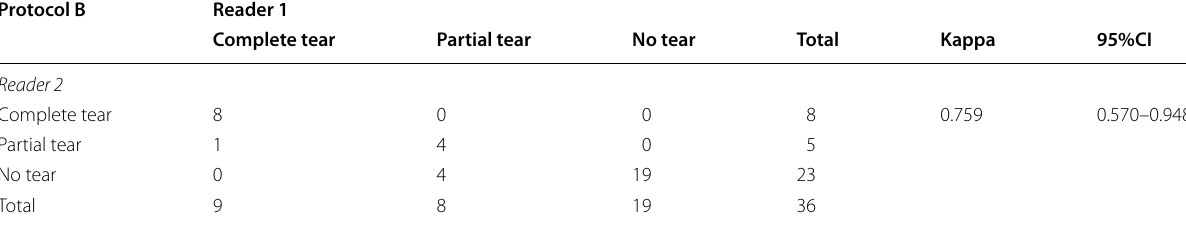
Table 8 Interobserver agreement between the two readers in imaging with protocol B Protocol B